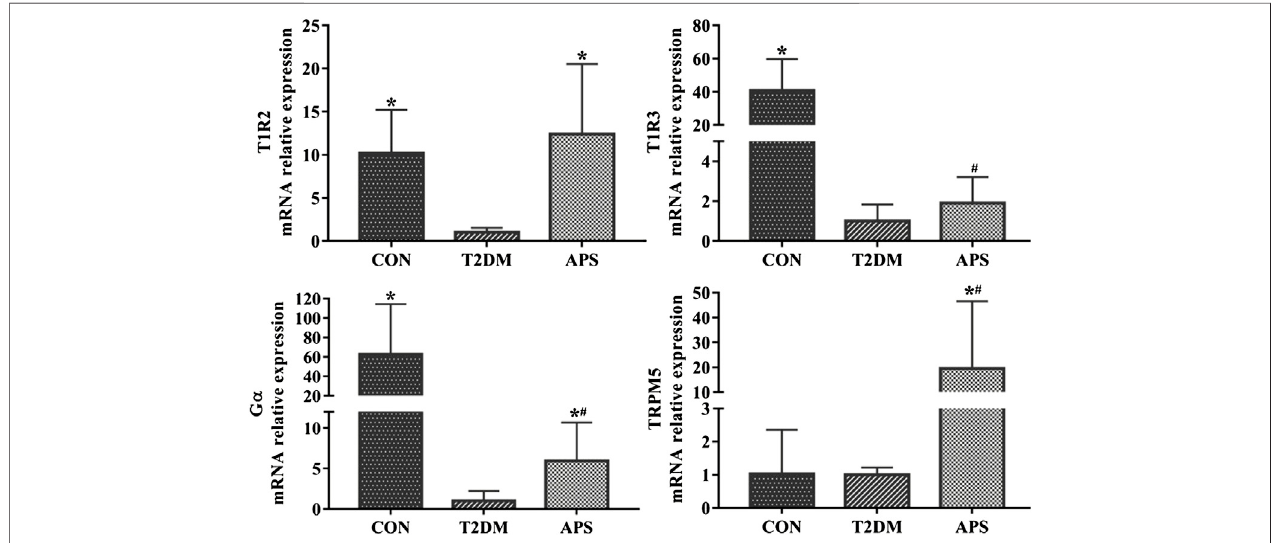
FIGURE 2 | mRNA expressions of signaling molecules in STRs pathway in liver of experimental rats. * p < 0.05, compared with rats in T2DM group; # p < 0.05, compared with rats in CON group.